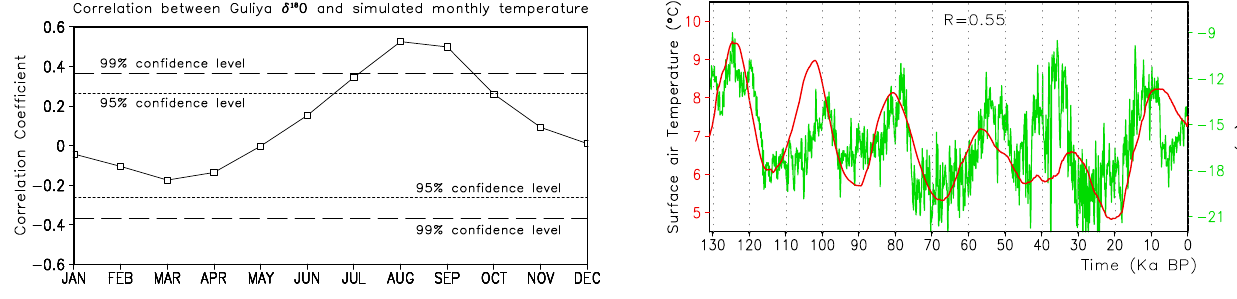
Fig. 2 . Correlation coefficients (open squares) between the Guliya δ 18 O - Fig. 2. Correlation coefficients (open squares) between the Guliya temperature proxy record and the simulated Guliya monthly mean SAT with the δ 18 O-temperature proxy record and the simulated Guliya monthly mean SAT with the 1308 samples. The horizontal short-dashed 1308 samples. The horizontal short-dashed and long-dashed lines indicate the and long-dashed lines indicate the 95 and 99% confidence levels, respectively. 95% and 99% confidence levels, respectively.